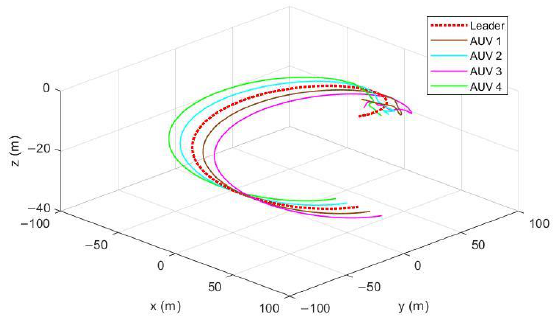
Figure 4. 3D simulation diagram of the AUV formation.